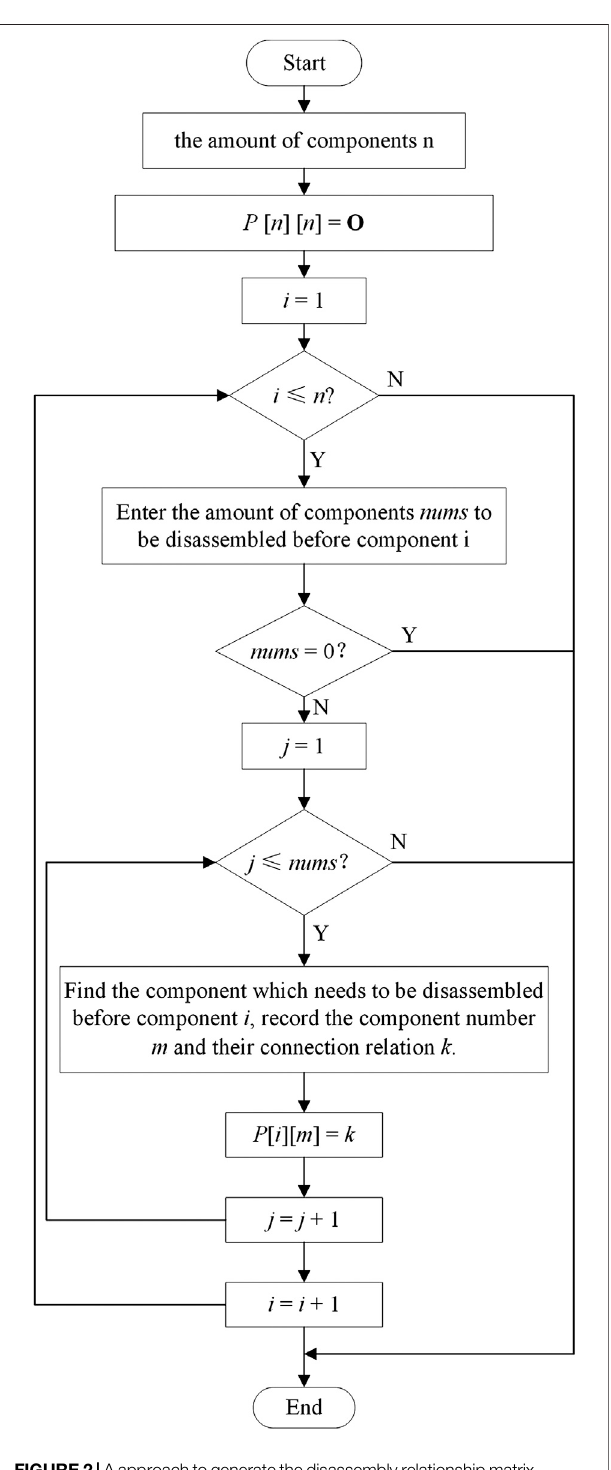
FIGURE2| Aapproachtogeneratethedisassemblyrelationshipmatrix.